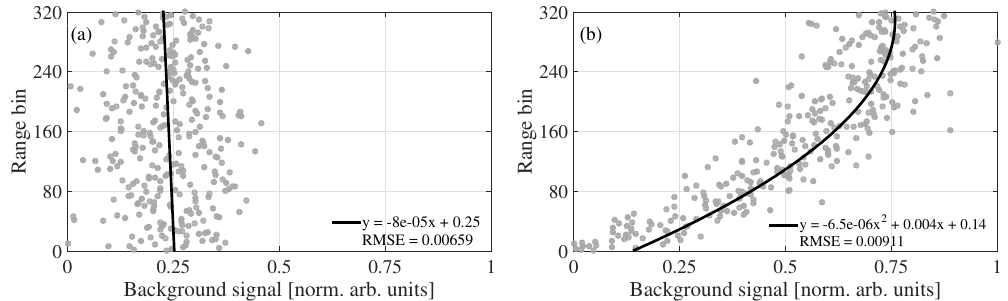
Figure 2. Two examples of background profiles with fitted polynomials emphasising the shape of the background. (a) Linear background pro- file measured on 21 June 2014, 13:00:21UTC. (b) Second-order polynomial background profile measured on 21 June 2014, 12:00:20UTC.